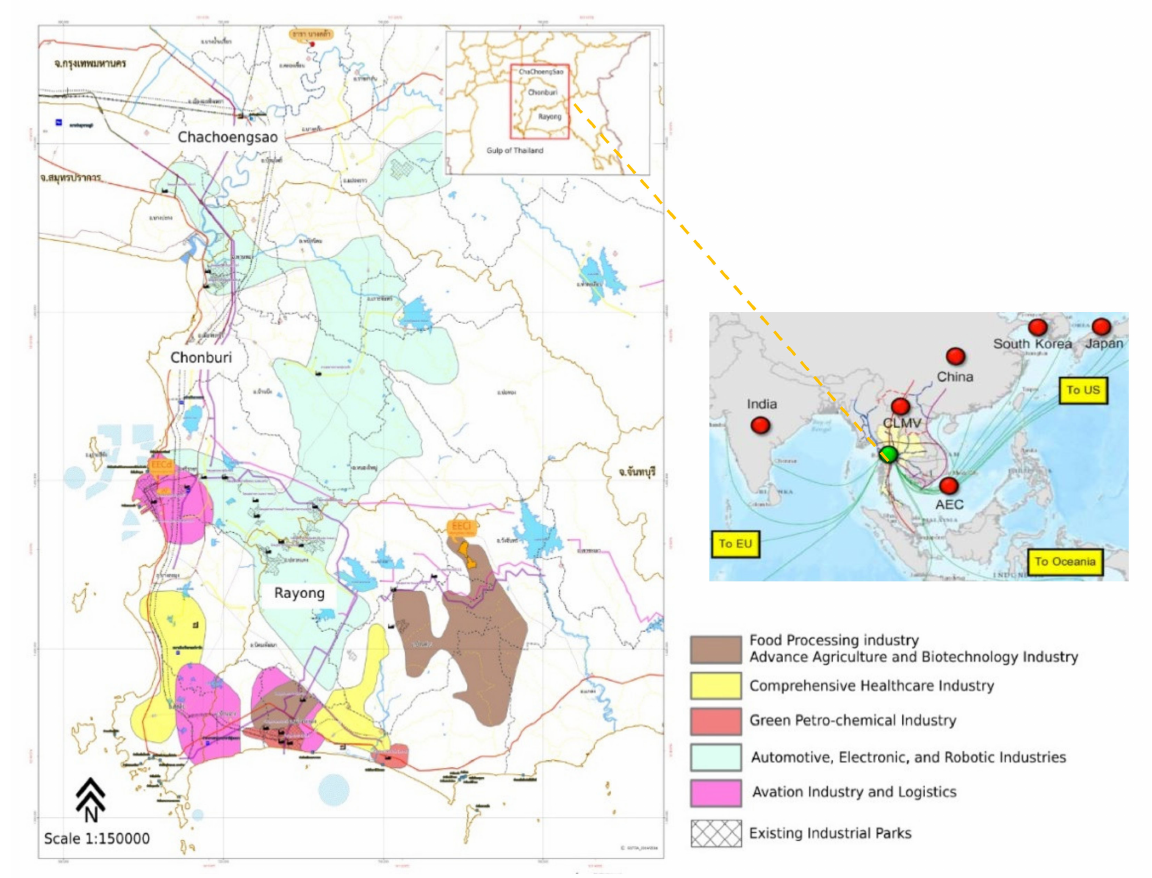
Figure 1. The study site (Eastern Economic Corridor,